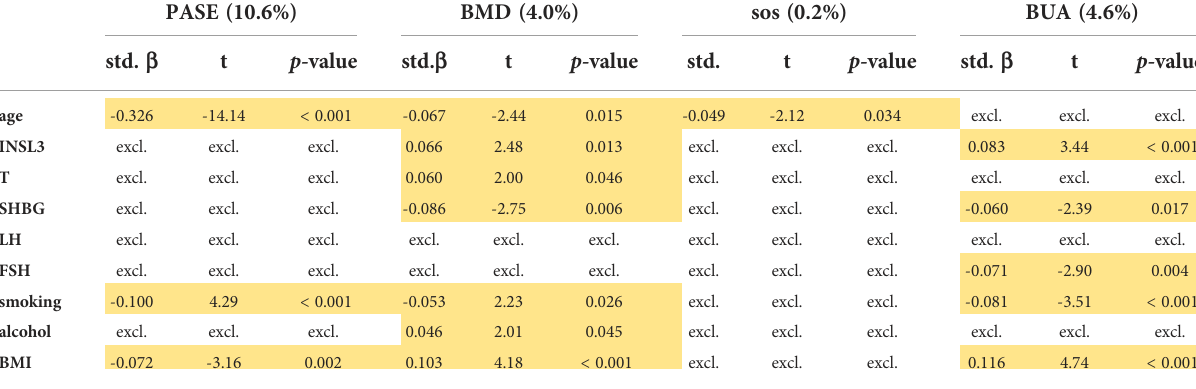
TABLE 1 Multiple regression analysis modelling the PASE (Physical Activity Scale for the Elderly) index, as well as BMD (bone mineral density), SOS (ultrasound speed of sound), and BUA (bone ultrasound attenuation) for heel bone ultrasound assessment as continuous dependent variables, using hormonal, anthropometric, and lifestyle parameters as independent variables, as indicated, including INSL3.